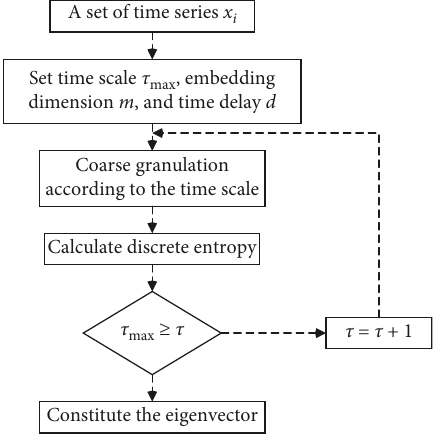
Figure 3: Flow chart of